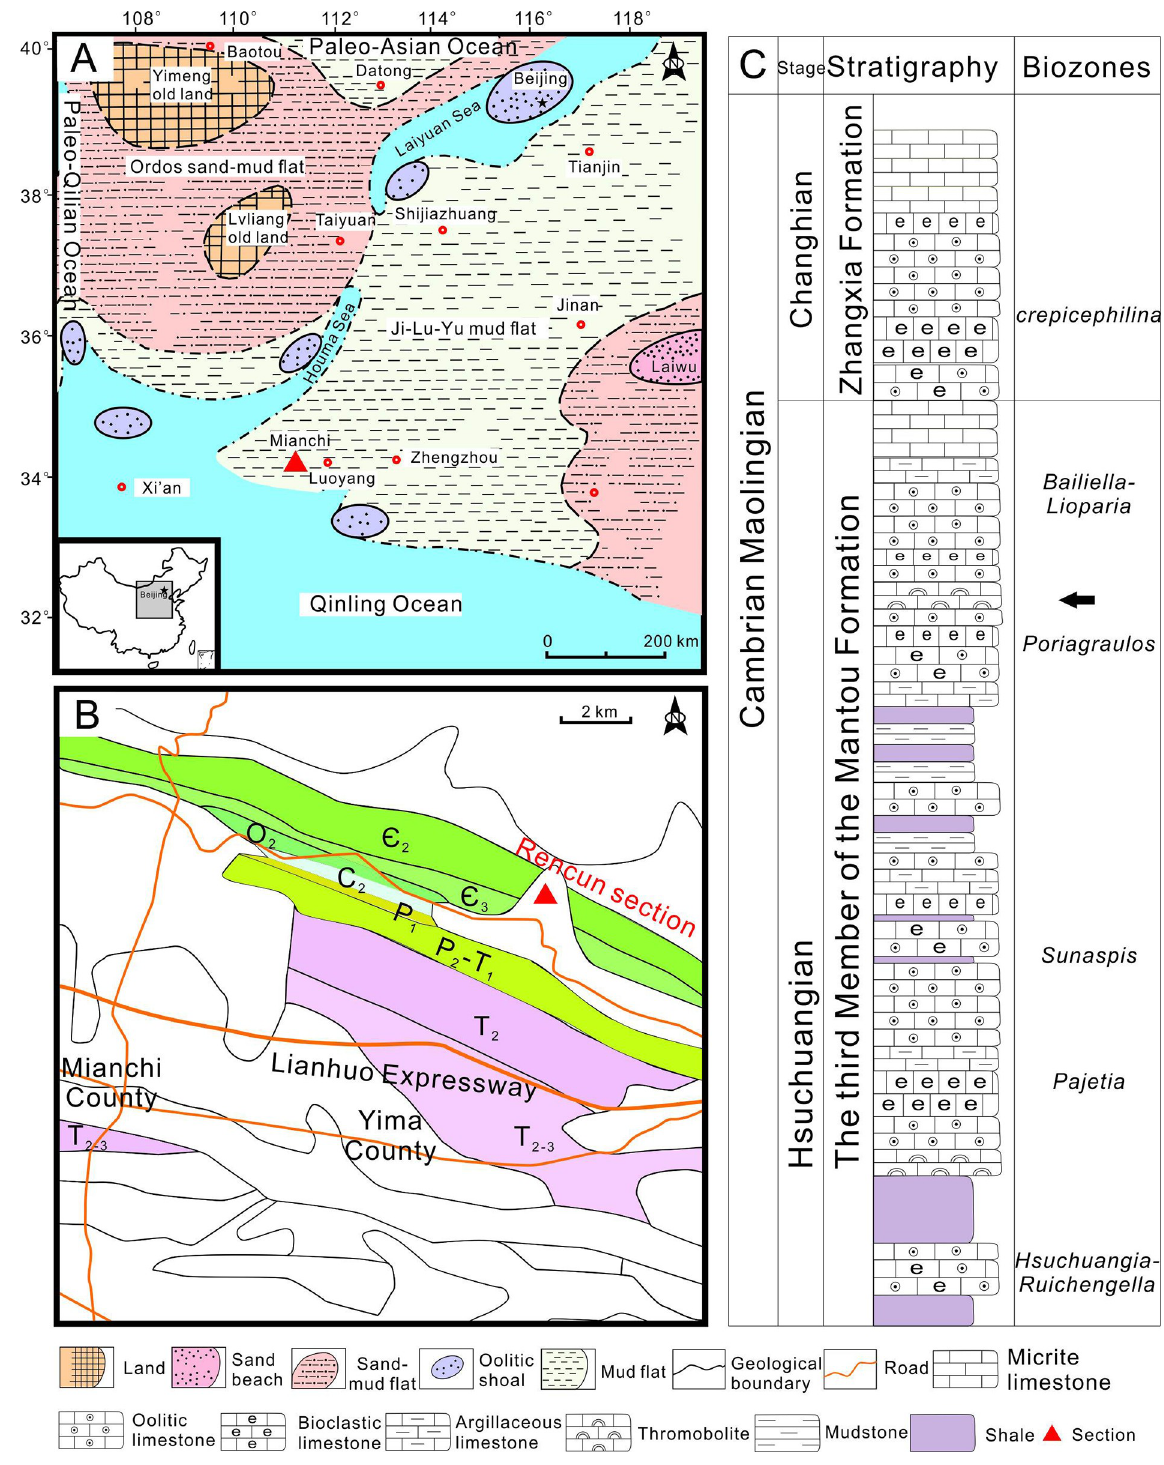
Fig 1. The geological setting and stratigraphy of the study area. (A) Paleogeography of the North China Platform in the early period of Cambrian Epoch 3 (modified after Feng [21]). (B) Simplified geological map of the Mianchi area. The white area corresponds with the Quaternary. (C) Stratigraphic column of M 3 Fm. in the Rencun section. The black arrow indicates fossil beds.